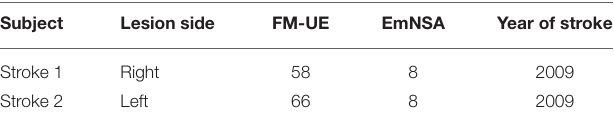
Frontiers in Neural Circuits |